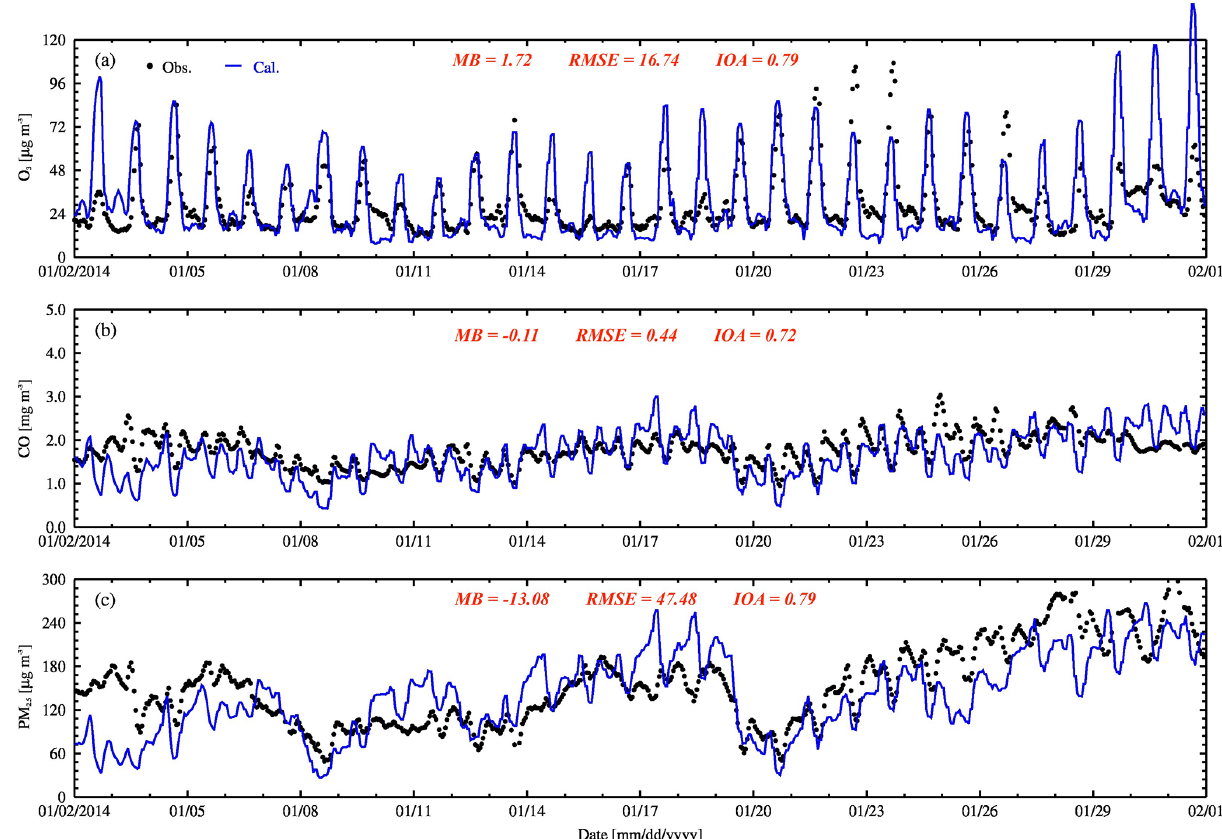
Figure 4. Comparison between the observed (black dots) and simulated (blue line) hourly O 3 (µgm − 3 ), CO (mgm − 3 ) and PM 2 . 5 mass concentration (µgm − 3 ) over the Sichuan Basin in January 2014.